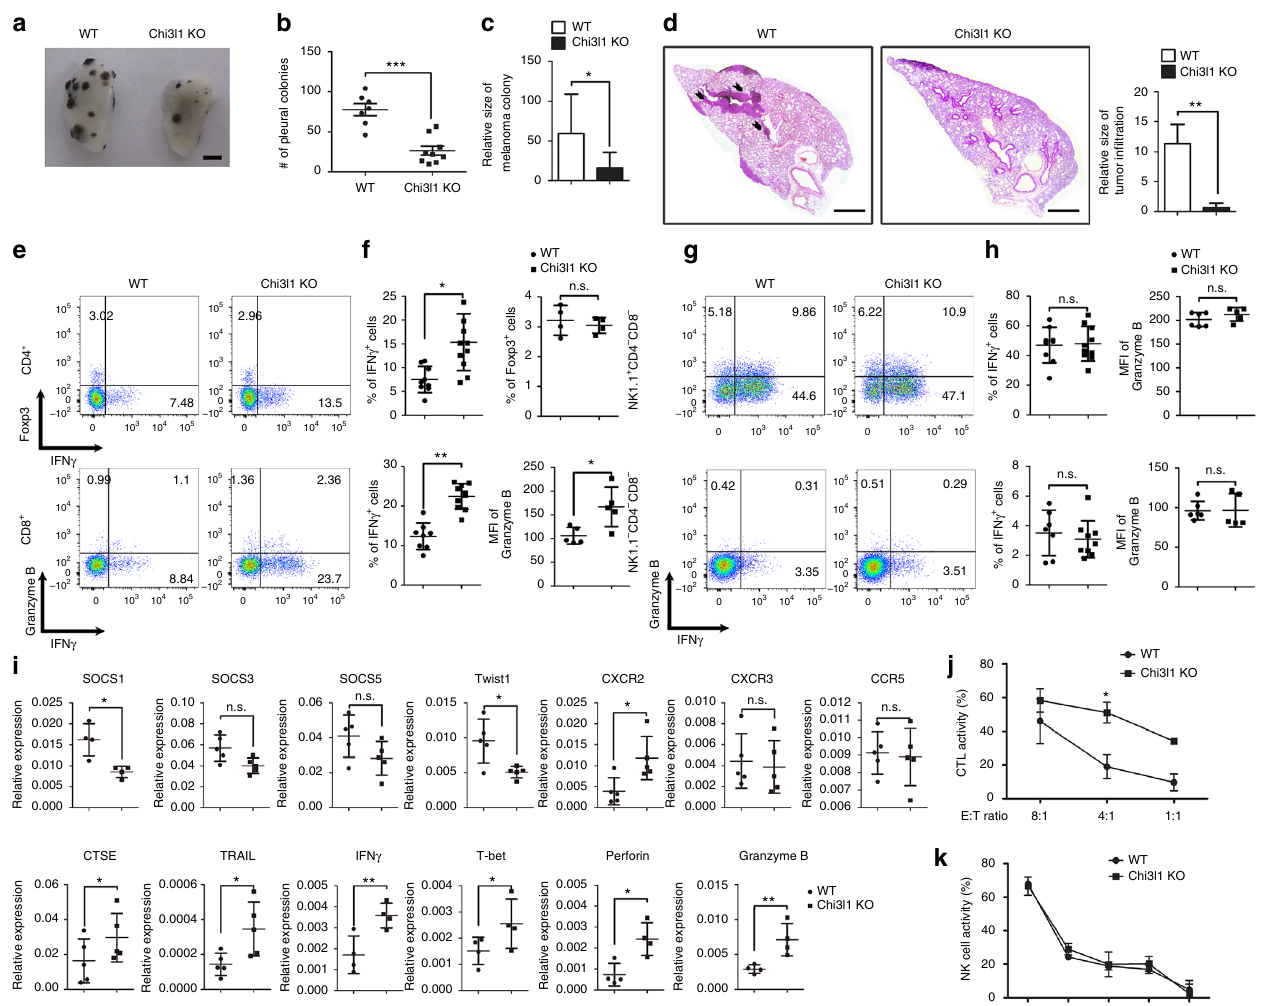
Fig. 6 Chi3l1 KO mice have reduced pulmonary metastasis with increased IFN γ -producing CD4 and CD8 T cells in the lung. a Representative lung image from B16F10 melanoma injected WT and Chi3l1 KO mice. Scale bar, 2 mm b Number of pleural colonies in each lung was counted. Data are mean ± SEM of three sets of independent experiments and each dot in graphs represent an individual mouse. c Relative total tumor area in the lung was measured by Image J software 1.48 v. d Histology of lung sections by H&E staining, and in fi ltrated tumor region was measured by Image J software 1.48 v. Scale bar, 200 m. e , f IFN γ producing CD4 T cells, Foxp3 + regulatory T cells, IFN γ producing CD8 T cells, and Granzyme B expression in IFN γ + CD8 T cells in the lung was analyzed by intracellular cytokine staining. % of IFN γ + , % of Foxp3 + , and MFI of Granzyme B was represented as scattered graph. g , h IFN γ producing NK cells IFN γ producing non-lymphocytic population, and Granzyme B expression in IFN γ + NK cells and non-lymphocytic population in the lung was analyzed. % of IFN γ + , and MFI of Granzyme B was represented as scattered graph. i mRNA expression of genes related to cytotoxicity and Th1 effector functions was analyzed by quantitative RT-PCR. Each gene expression level was normalized to β -actin. j Cytotoxicity of WT and Chi3l1 KO CD8 T cells against B16F10 target cells at indicated E:T ratios. k NK cell activity was represented as tumor killing activity of WT and Chi3l1 KO NK cells against to B16F10 target cells at indicated E:T ratios. Data are mean ± SD of three sets of independent experiments and each dot in graphs represent an individual mouse. n.s., not signi fi cant; * p < 0.05, ** p < 0.01, *** p < 0.001 (two-tailed Student ’ s t